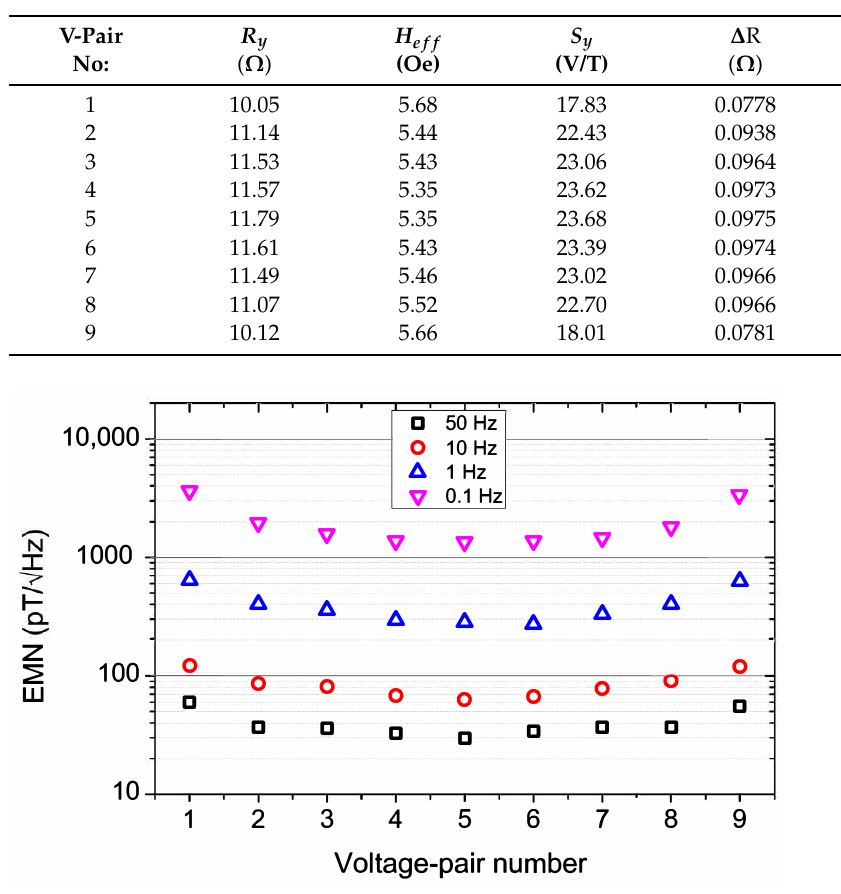
Figure 2. Plot showing the variation of EMN with the position of the voltage pairs for 50, 10, 1, and 0.1 Hz frequencies and for the highest excitation current of ∼ 130